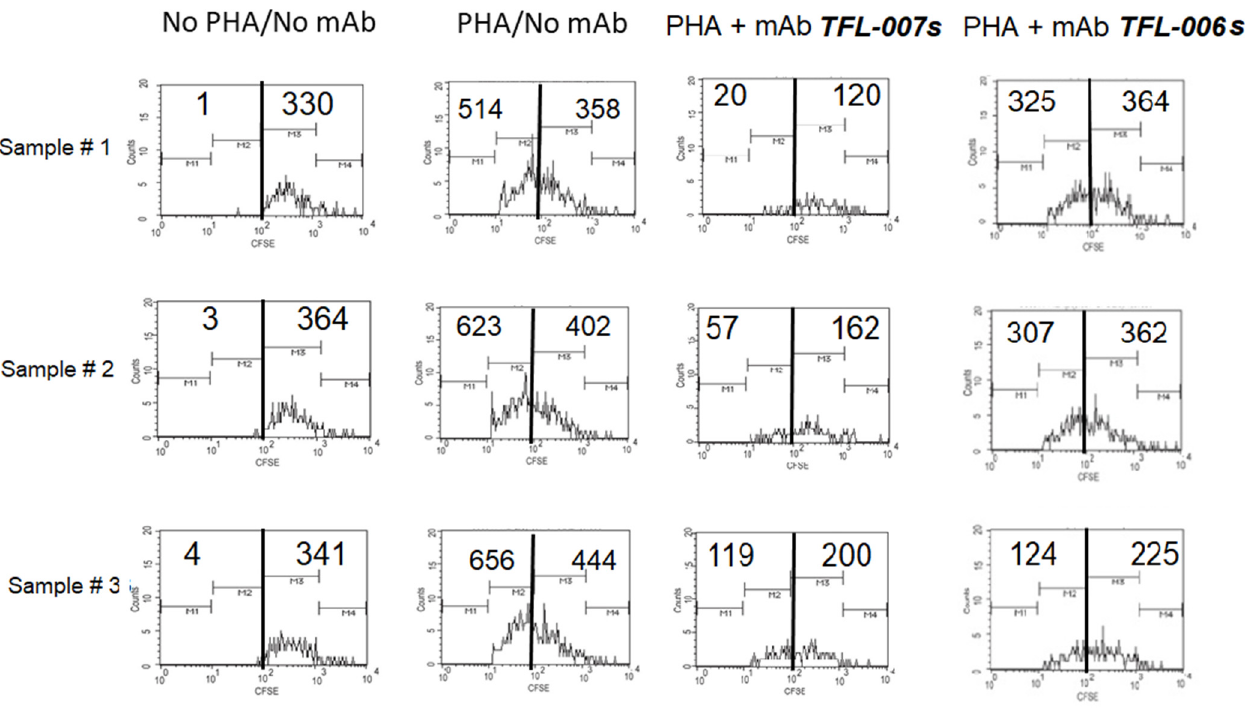
Figure 8. Suppression of proliferation of PHA-activated CD4+ T-cells by purified culture supernatant of anti-HLA-E mAb TFL-006s. Results of the triplicate analysis are presented. The numbers inside refer to cell counts. Refer to Figure 5A to understand the meaning of the shift in the profiles from right to left.